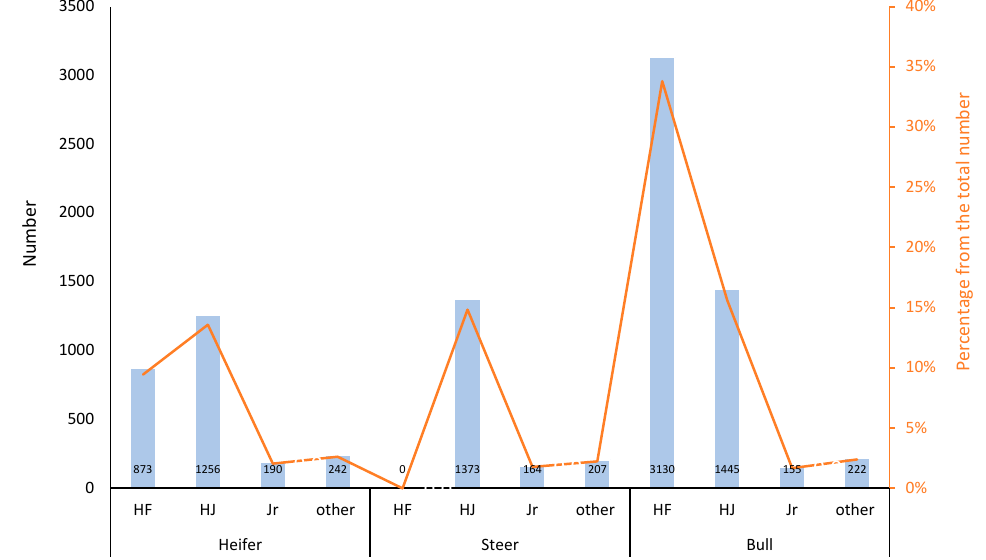
Figure 2. The average number of traditional finished heifer, steer, and bull across dam breed types in the ABM (left axis, blue bars) and percentage from the total number (right axis, orange line); HF: Holstein-Friesian; HJ: Holstein-Friesian–Jersey cross, Jr: Jersey and other cattle.